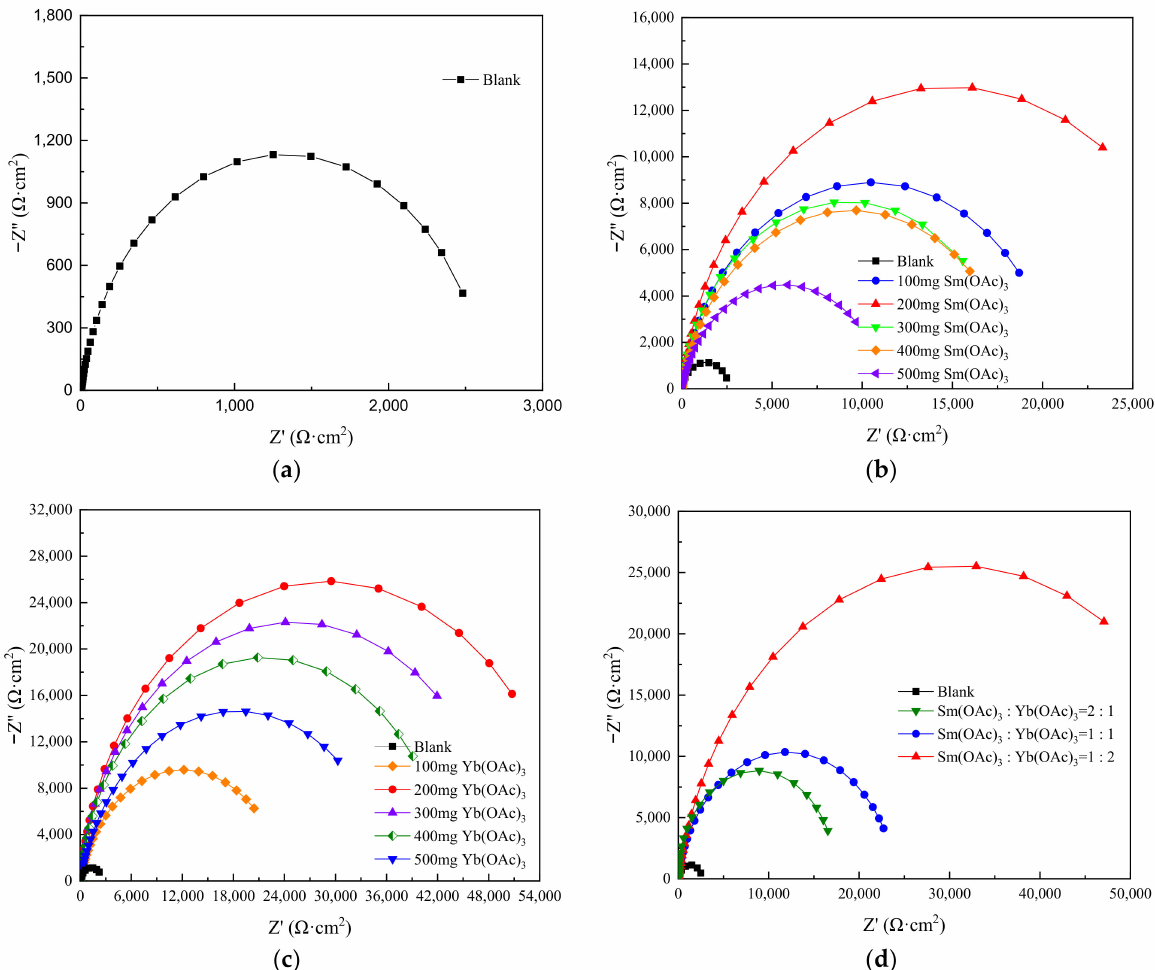
Figure 3. Nyquist plots of aluminum anode in 3.5 wt.% NaCl with different additives: ( a )